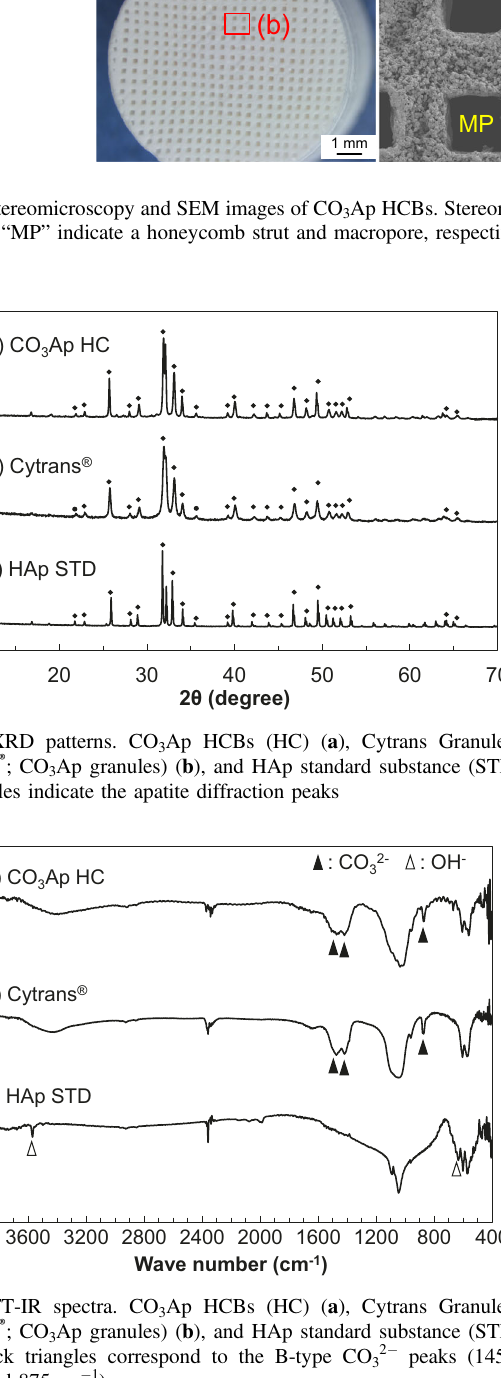
Fig. 5 FT-IR spectra. CO 3 Ap HCBs (HC) ( a ), Cytrans Granules ® (Cytrans ® ; CO 3 Ap granules) ( b ), and HAp standard substance (STD) ( c ). Black triangles correspond to the B-type CO 32 − peaks